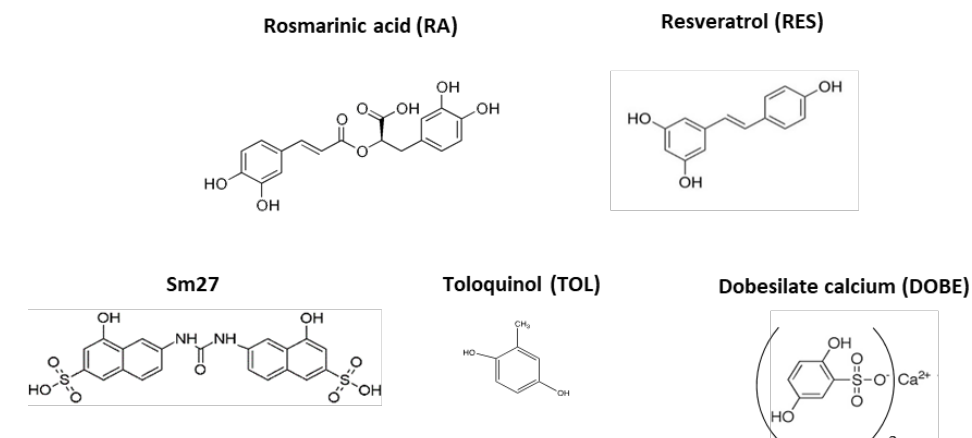
Scheme 1. The natural polyphenolic compound, rosmarinic acid (RA, Scheme 1 and Figure 1C), interacts with FGFR, inhibiting FGFR phosphorylation and FGF2-induced endothelial cell proliferation [26]. A variety of NMR approaches provide a molecular-level description of the interactions of RA with the FGF2/FGFR-D2 complex and both FGF2 and FGFR-D2 separately, showing that RA binds the FGFR-D2 domain and destabilizes the complex through direct and allosteric perturbations [24].